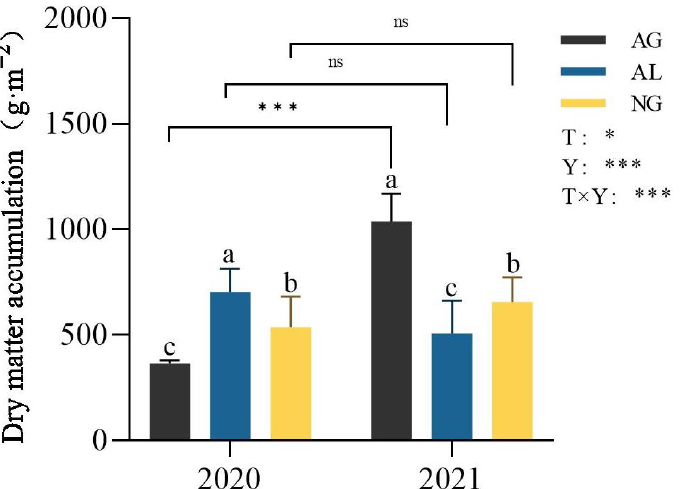
Figure 2. Dry matter accumulation between land use types in 2020 and 2021. AG: artificial grassland; AL: cropland; NG: natural grassland; T: land use type; Y: year; T × Y: interaction of land use type and year. Lowercase letters indicate the significant difference of dry matter accumulation among different land use types in the same year ( p < 0.05). The asterisk indicates a significant difference between two years for the same land use type. *, ***, ns represent p < 0.05, p < 0.001, p > 0.05, respectively. Data are shown as mean ±